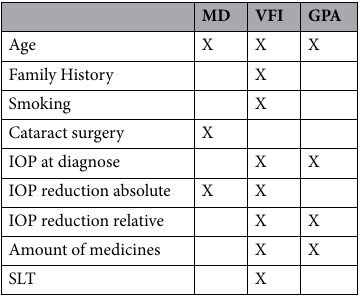
Table 4. Summary of the significant variables tested in the multivariate analysis according to the endpoints. MD Mean deviation; VFI Visual field index; GPA Guided progression analysis; IOP Intraocular